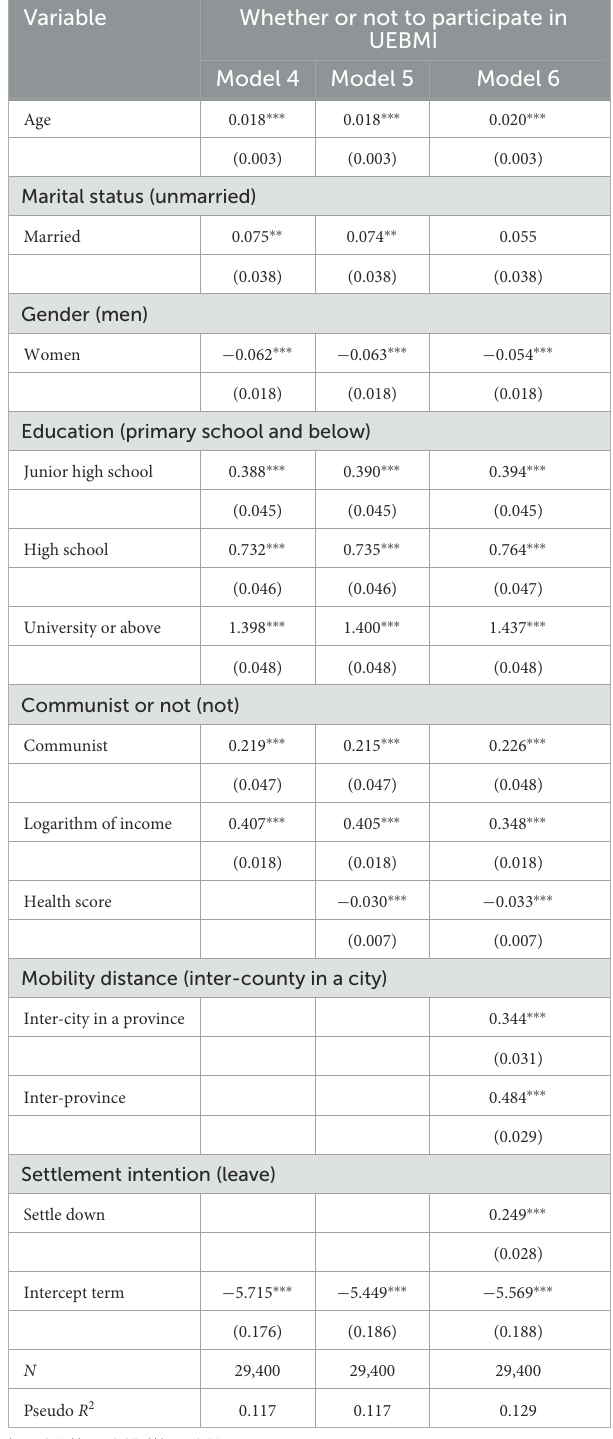
TABLE 3 Regression analysis results of whether or not to participate in health insurance.